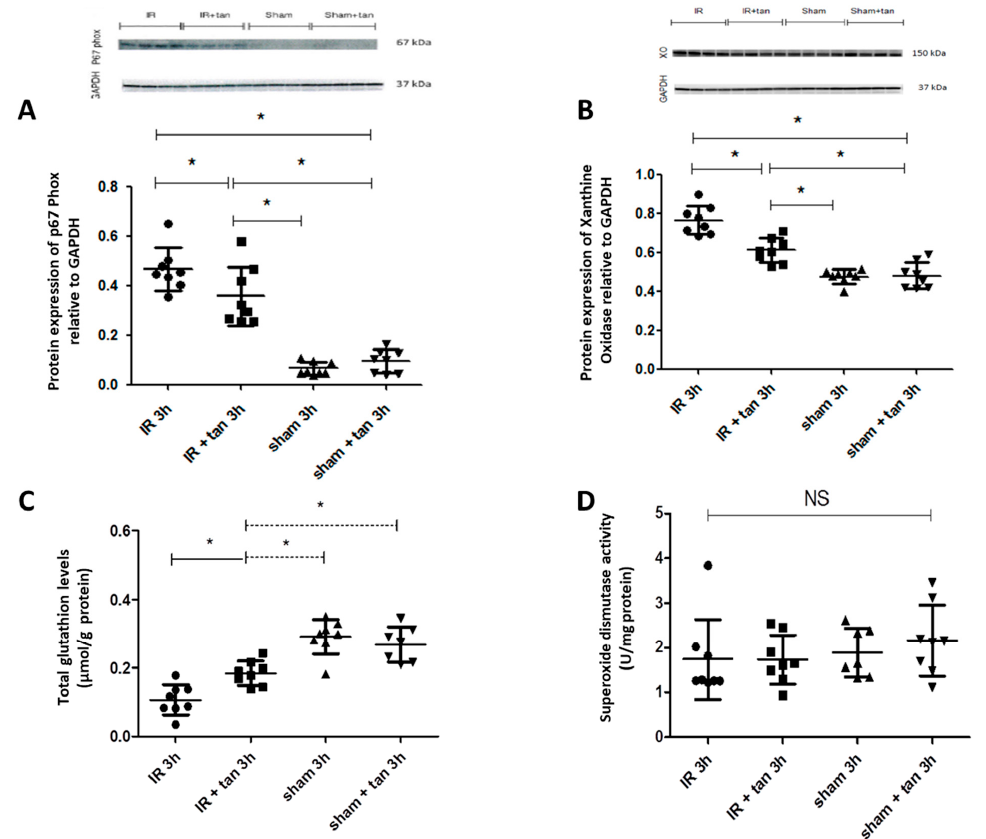
Figure 5. Tannic acid injection protects from oxidative stress development. In kidneys biopsies obtained 3 h after reperfusion following warm ischemia, tannic acid limits P67phox ( A ) and xanthine oxidase ( B ) expressions, and reduces the decrease in total glutathion ( C ) induced by ischemia–reperfusion injury, without effect on superoxide dismutase activity ( D ), n = 8, values are mean ± SD, * p < 0,05.